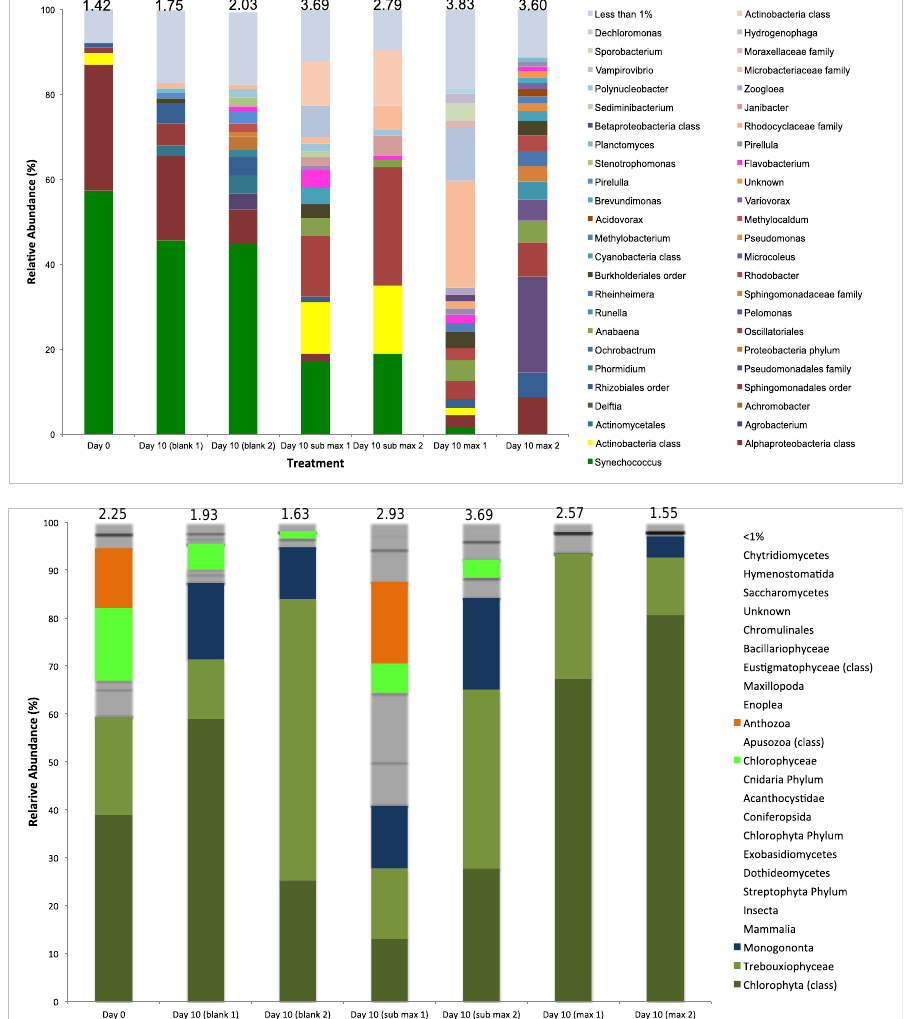
Figure 4. Relative gene abundance (%) of microorganisms identified within WRP sample, control (no harvesting), sub-maximum harvesting, and maximum harvesting (in biological replicates). The 16S rDNA bacterial abundance is shown at a genus level except when indicated ( top ) and 18S rDNA eukaryotic abundance is shown at a class level except when indicated ( bottom ). Algae (eukaryotic microalgae and prokaryotic cyanobacteria) are shown in shades of green. The Shannon diversity indices based on OTUs are shown at the top of each column.